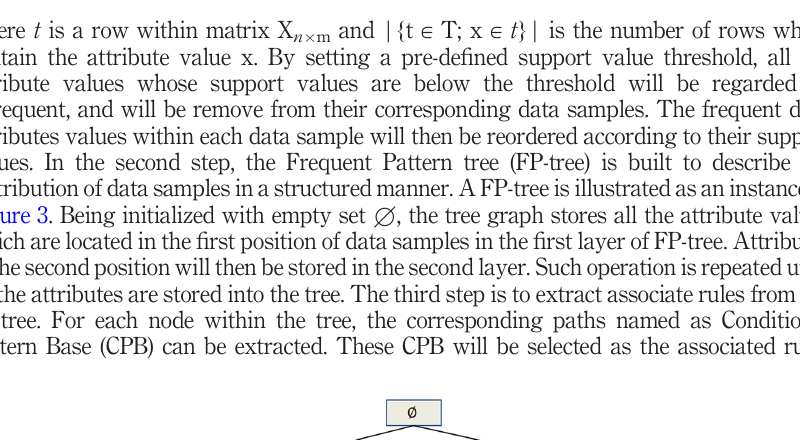
Figure 3. A sample FP-tree generated by association